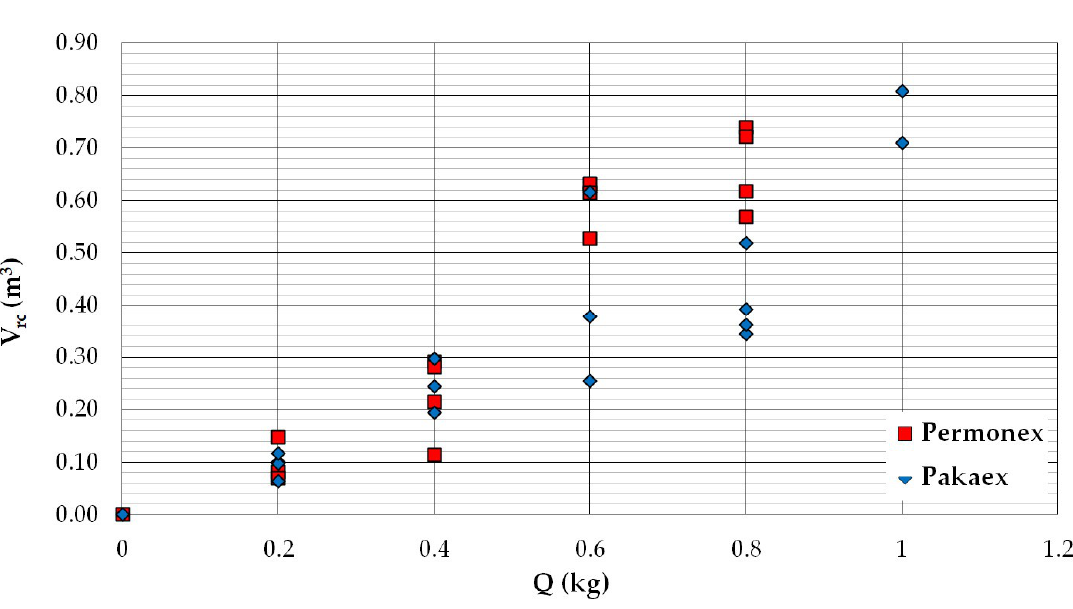
Figure 11. The dependence of diameter of enlargement D re (m) on the mass of explosive charge Q (kg), for Permonex V19 and Pakaex.